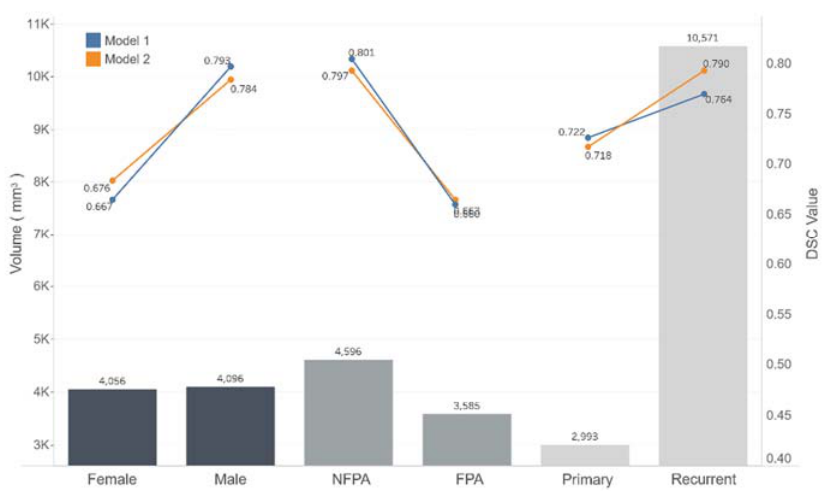
Figure 7. Relationships between mean volumes and DSC values of the male and female, NFPA and FPA, and primary and recurrent subgroups. DSC values increased with increasing mean volume in each subgroup. (NFPA: nonfunctional pituitary adenoma, FPA: functional pituitary adenoma).